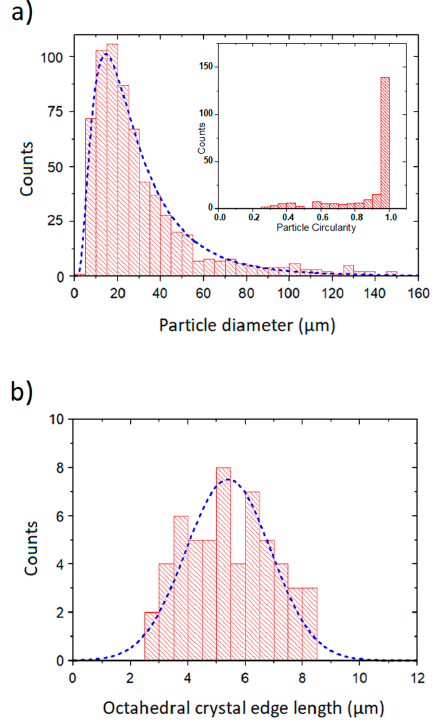
Figure 5. Size distribution for the ( a ) spherical particles and ( b ) octahedral inner crystals with corresponding distribution curves marked by blue lines. The inset shows the distribution of particles circularity.